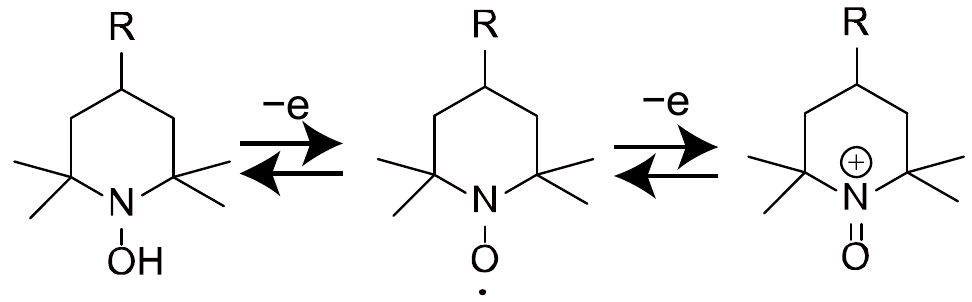
Figure 1. Reversible redox system based on nitroxyl radicals. The oxoammonium cation can be used in stoichiometric quantities or generated elec- trochemically in situ, or through the use of a variety of secondary oxidants [29]. Therefore, in the case of LbL films driven by electrostatic interactions, the stability of thin films composed of TEMPO derivatives should be dependent on the electrode potential. We previ- ously reported that LbL films prepared by a combination of TEMPO-modified polyacrylic acid (PAA) and polyethyleneimine (PEI) were decomposed by application of an electric potential [30]. This is due to the oxidation of the TEMPO derivative, and the increase in the positive charge density of the weak polyelectrolyte degrades the balance of the thin film driven by the electrostatic interaction, which leads to decomposition of the LbL film (Figure